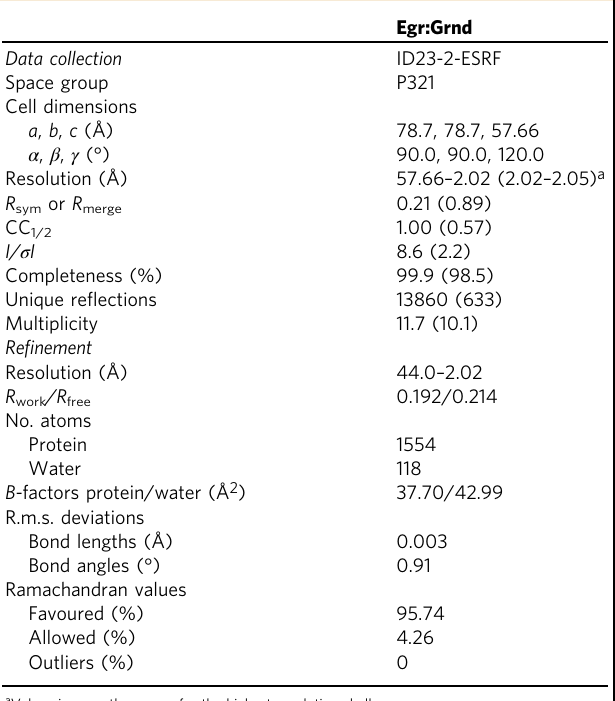
Table 2 Data collection and re fi nement statistics of the Egr: Grnd